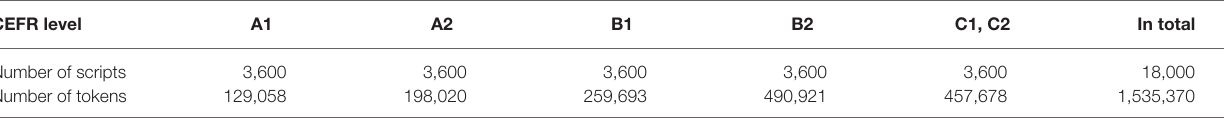
TABLE 1 | Summary of randomly extracted learner